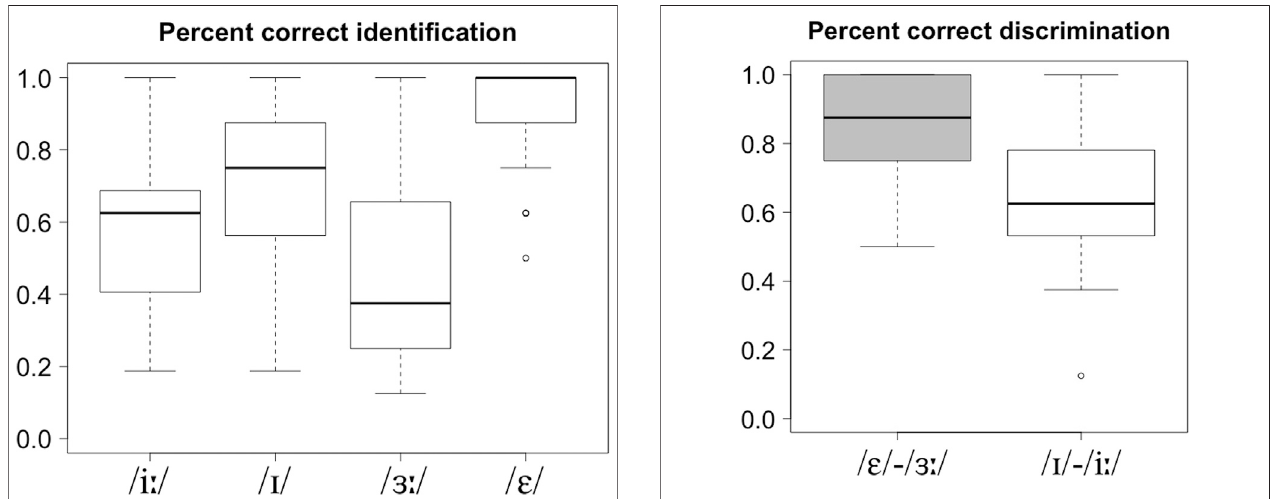
FIGURE1| Boxplotsofidenti fi cationaccuracyforeachofthefourtarget English vowels. Boxplots represent the quartile ranges of the scores (top of box: 75th percentile, bottom of box; 25th percentile; line in the middle: median). The whiskers represent the highest and lowest values that are not outliers or extreme values, which are indicated by circles outside the whiskers.